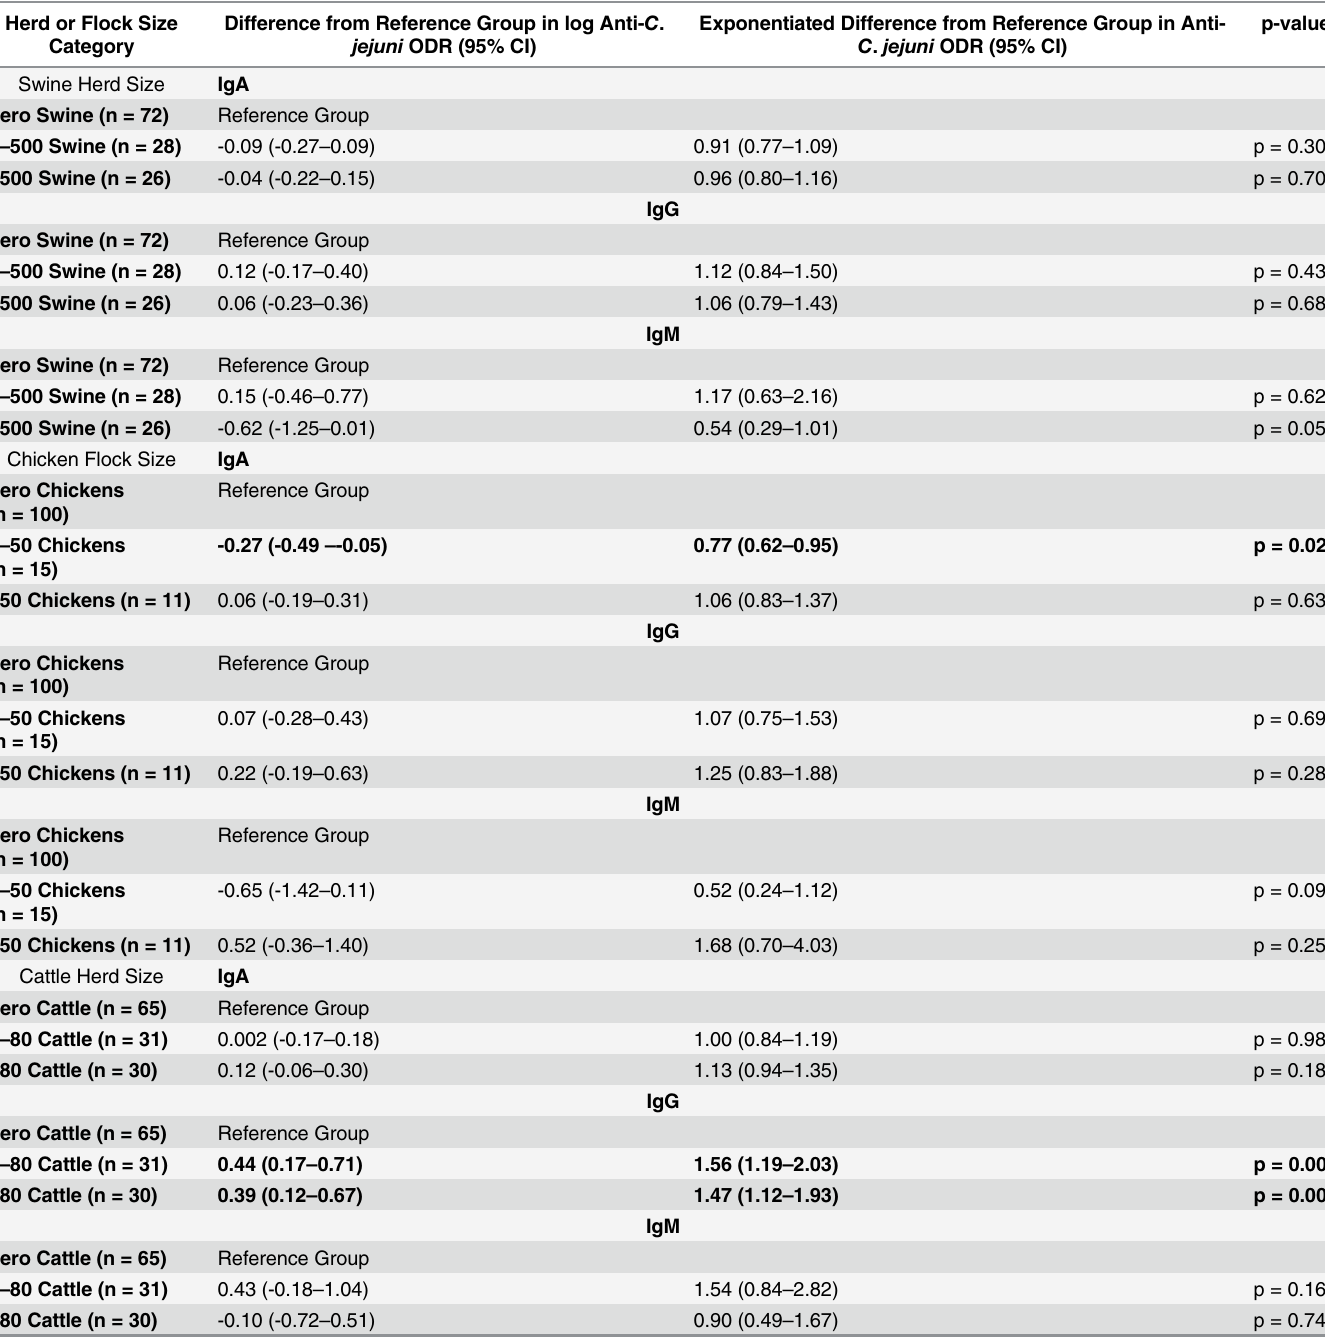
Table 4. Anti- C . jejuni Antibody Optical Density Ratios (ODR) by Animal Herd or Flock Size in 2005 – 2006 for Male AHS Farmers. Herd or Flock Size